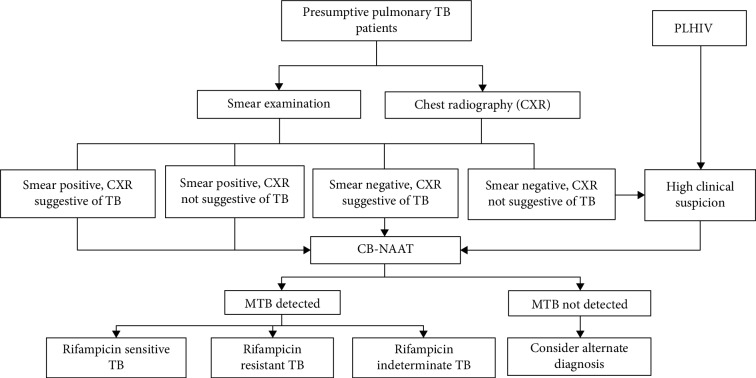
Recommendations for chest radiography and CB-NAAT for the evaluation of presumptive pulmonary TB patients as per the integrated diagnostic algorithm of the Government of India's Revised National TB Control Programme (2017).